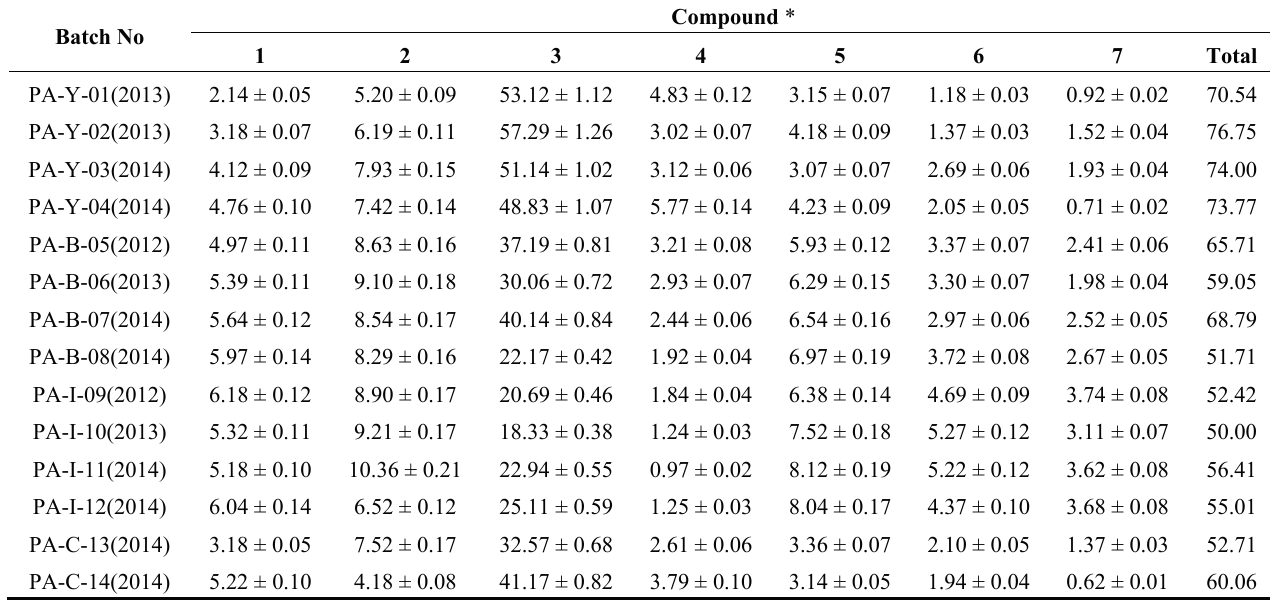
Table 6. Content of seven compounds in P. anserina herb, mg·g − 1